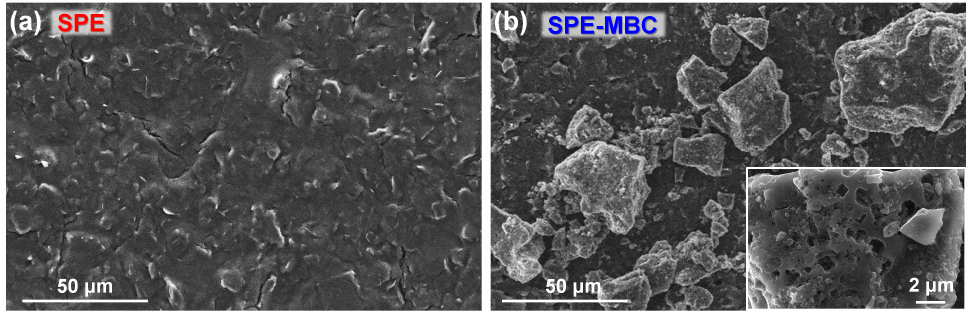
Figure 5. SEM top-view images of ( a ) the bare SPE and ( b ) the SPE after biochar drop-casting deposition (Inset: magnified top-view image).